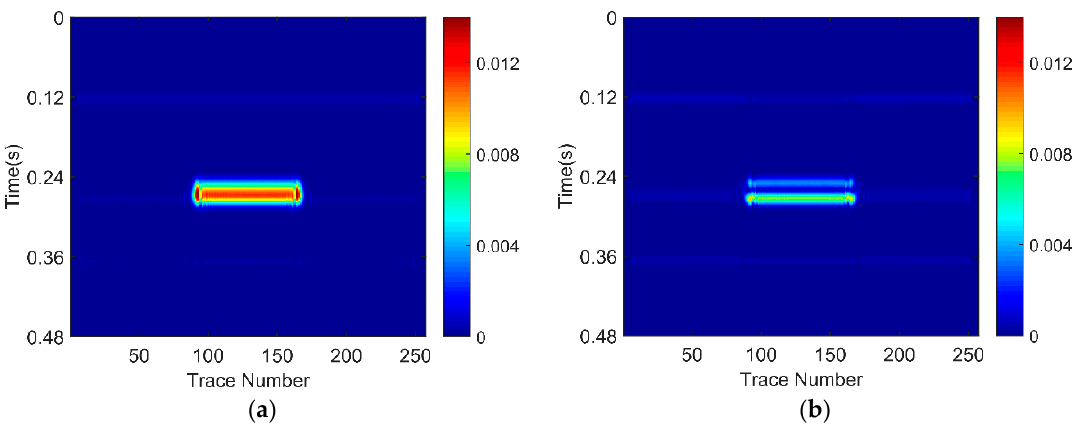
Figure 7. Constant frequency sections: ( a ) at 44 Hz; and ( b ) at 54 Hz.